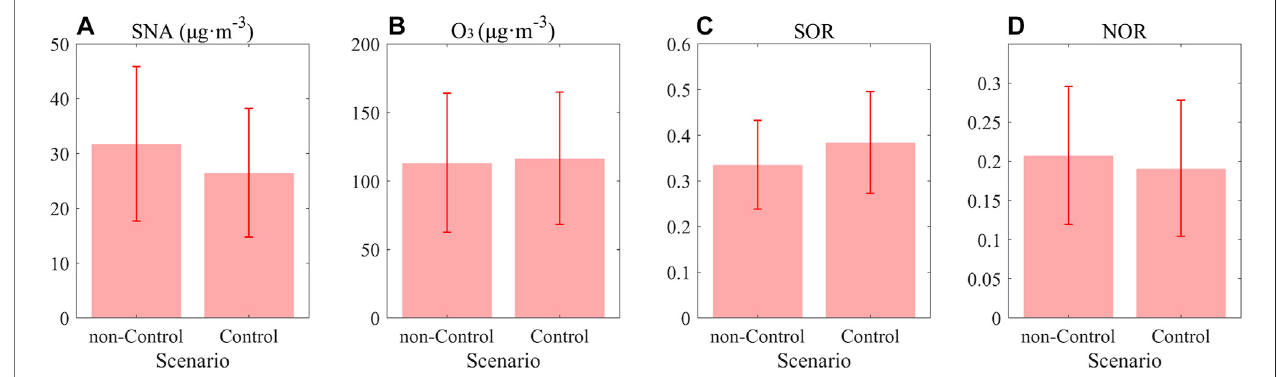
FIGURE 7 | The comparison between in non-Control scenario versus Control for (A) SNA concentration, (B) O 3 concentration, (C) SOR and (D)